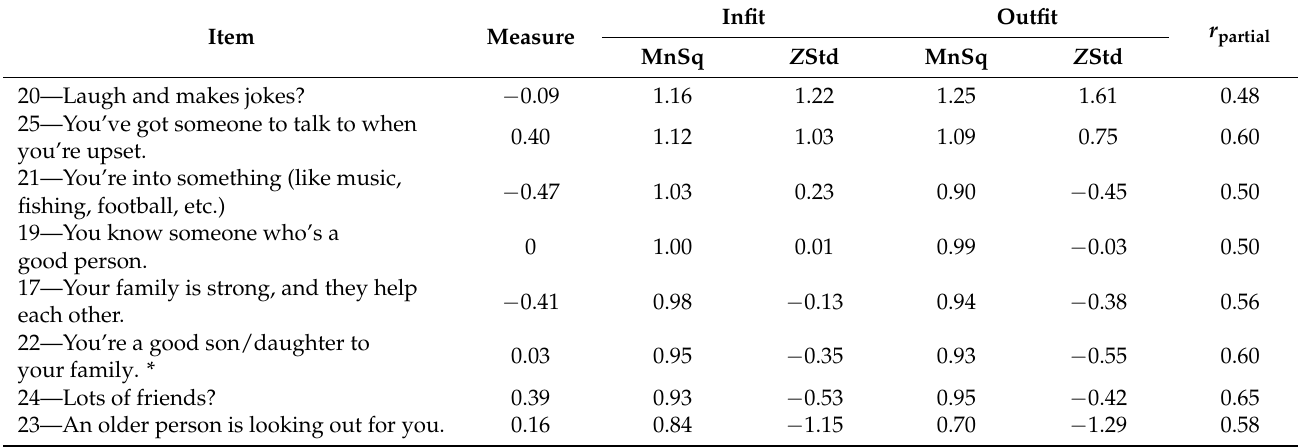
Table 4. Resilience item difficulties, fit, and measure correlations in order of descending